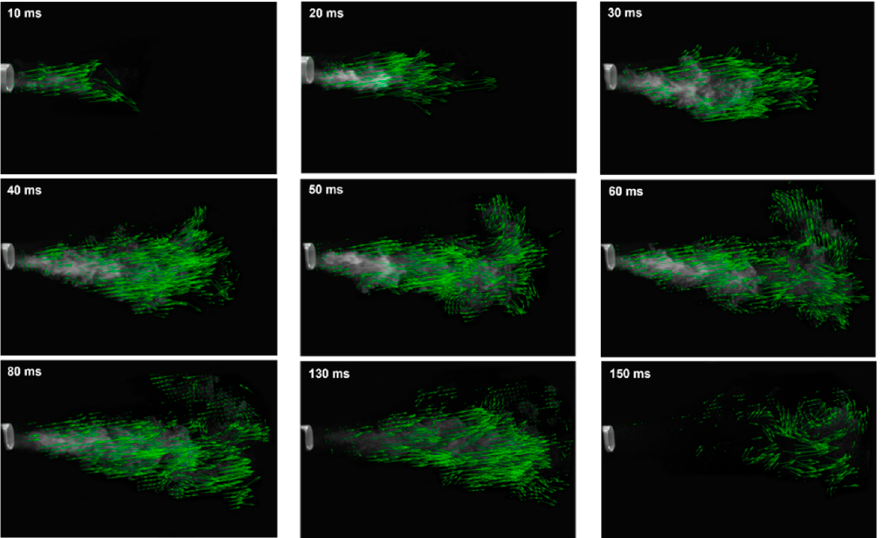
Figure 4. PIVlab-analyzed velocity fields of the MDI spray plume at varying instants after actuation (10–150 ms).